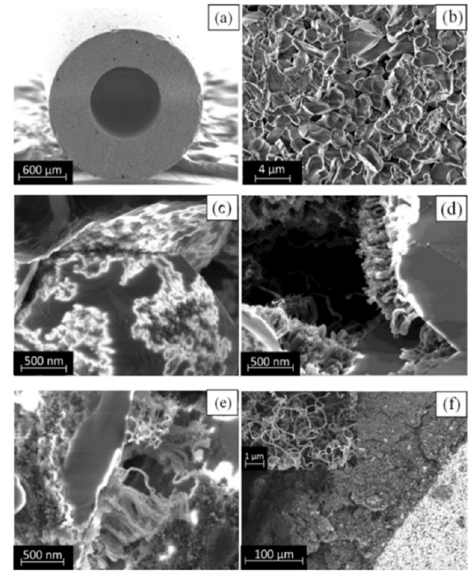
Figure 5. CNF film grown on a hollow alumina fiber; ( a ) low magnification and ( b ) high magnification SEM images of the hollow alumina fiber; CNF grown on alumina fiber using different Ni solutions: ( c ) 0.02 g/L, ( d ) 0.2 g/L, ( e ) 1.0 g/L, and ( f ) 5.0 g/L. [110].